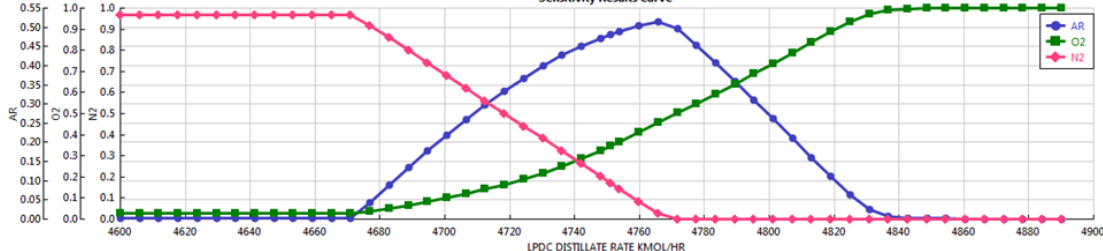
Figure 11. ARO2RECT molar fractions vs. LPDC Distillate rate.